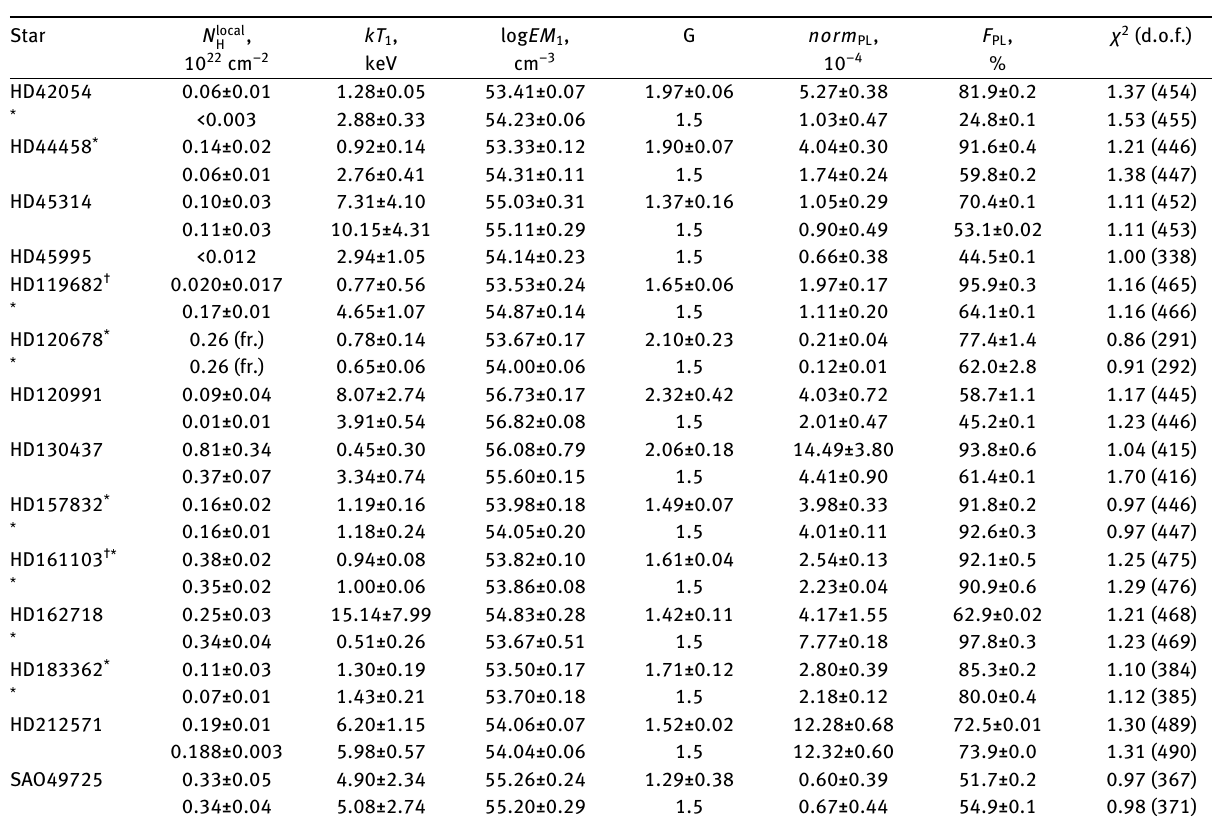
Table 6. The same as in Table 3 but for APEC/MEKAL+PL